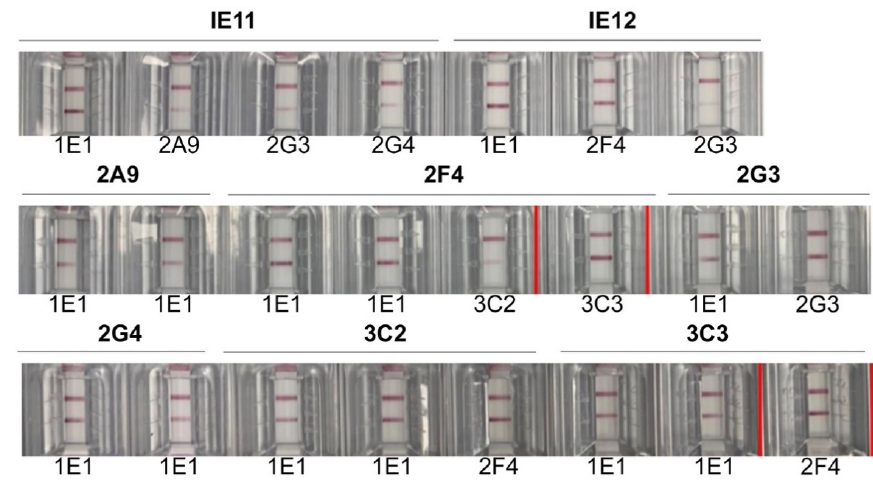
Figure 5. Selection of MAb pairs through sandwich LFA method. The effective MAb pair is marked with red-colored boundaries.